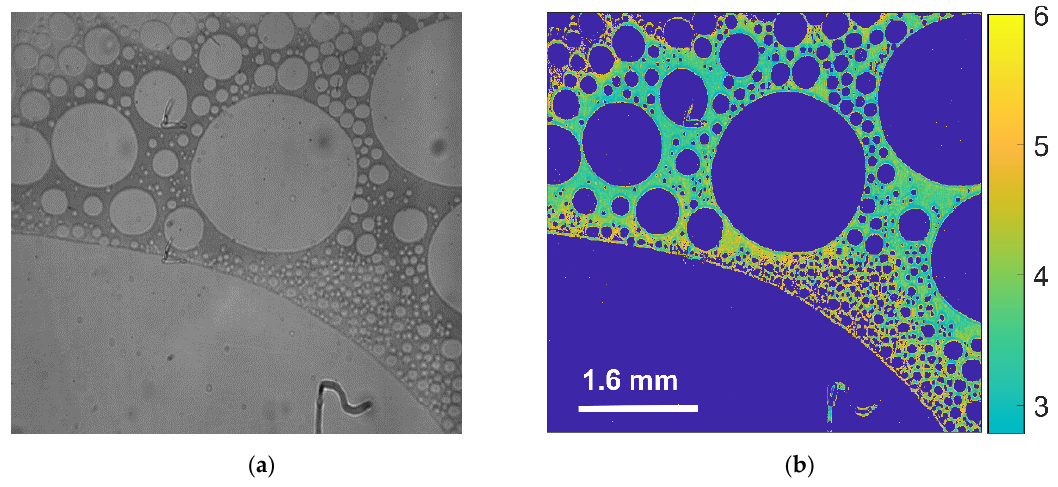
Figure 6. Formation of multilayer water film between droplets during Stage II of USDC, ( a ) recorded image using SPRi at 680 nm, and ( b ) processed image with thickness map; dark blue represents the droplet of